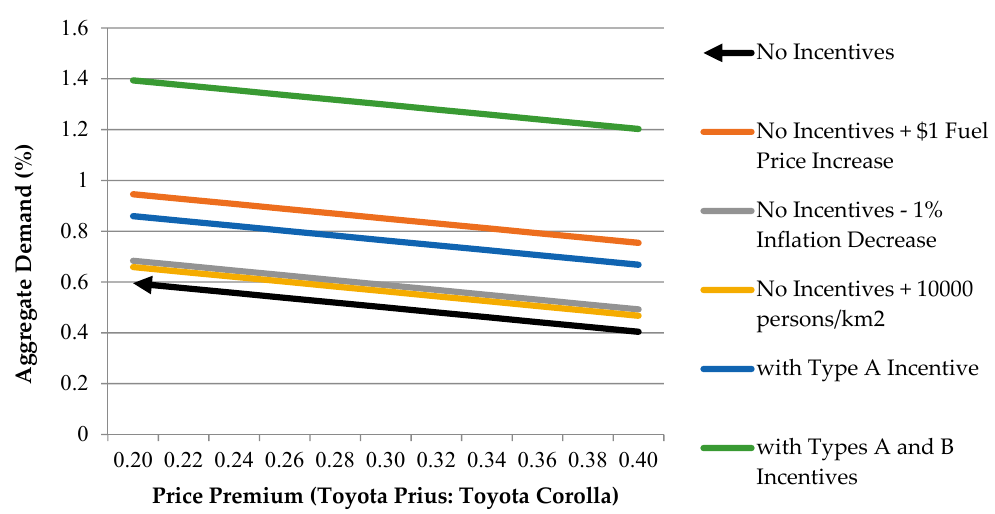
Figure 5. Aggregate Demand as a function of Price Premium for various scenarios .